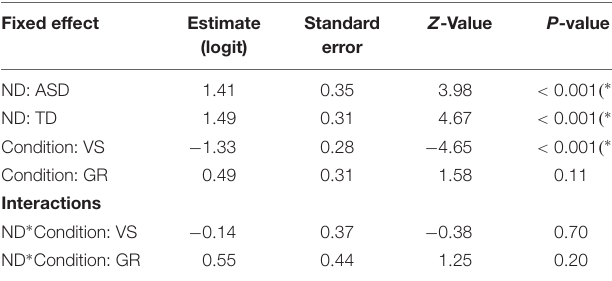
TABLE 4 | output of the mixed model analyzing the number of trials where the first fixation landed on the face in the two groups.